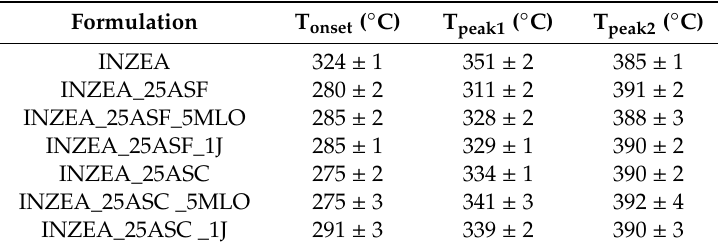
Table 3. T onset and T peak values of INZEA-based biocomposites with 25 wt % of ASP at the two grinding levels with and without MLO or Joncryl compatibilizers (mean ± SD, n = 3). Formulation T onset ( ◦ C) T peak1 ( ◦ C) T peak2 ( ◦ C) INZEA 324 ± 1 351 ± 2 385 ±